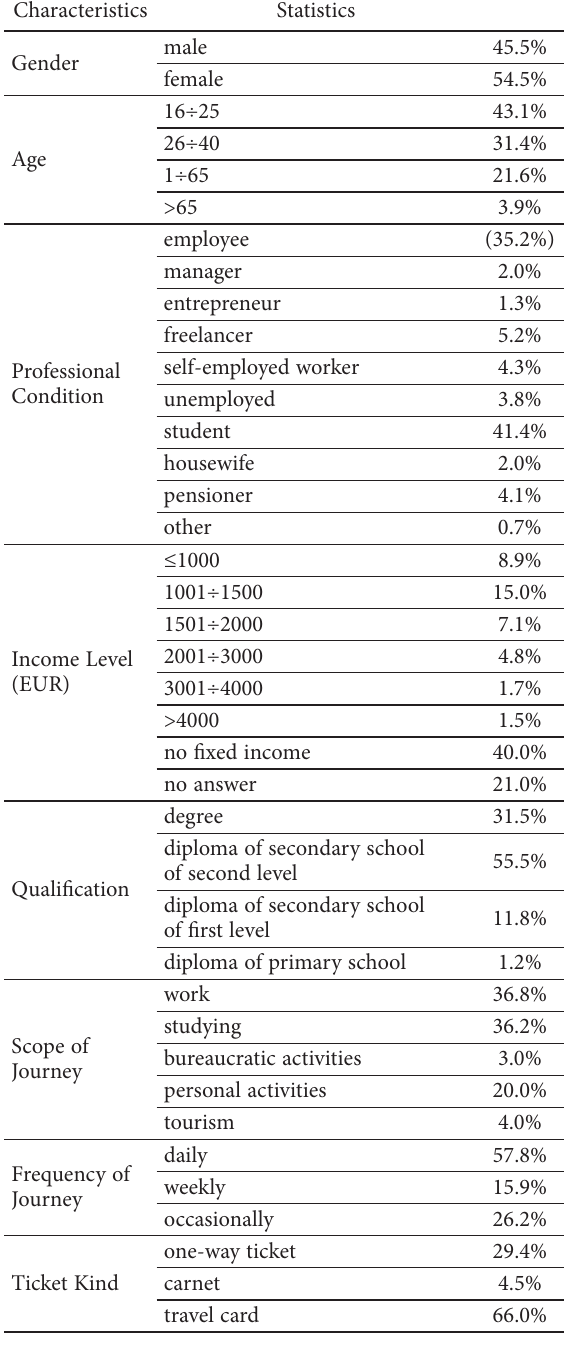
Table 1. Sample characteristics